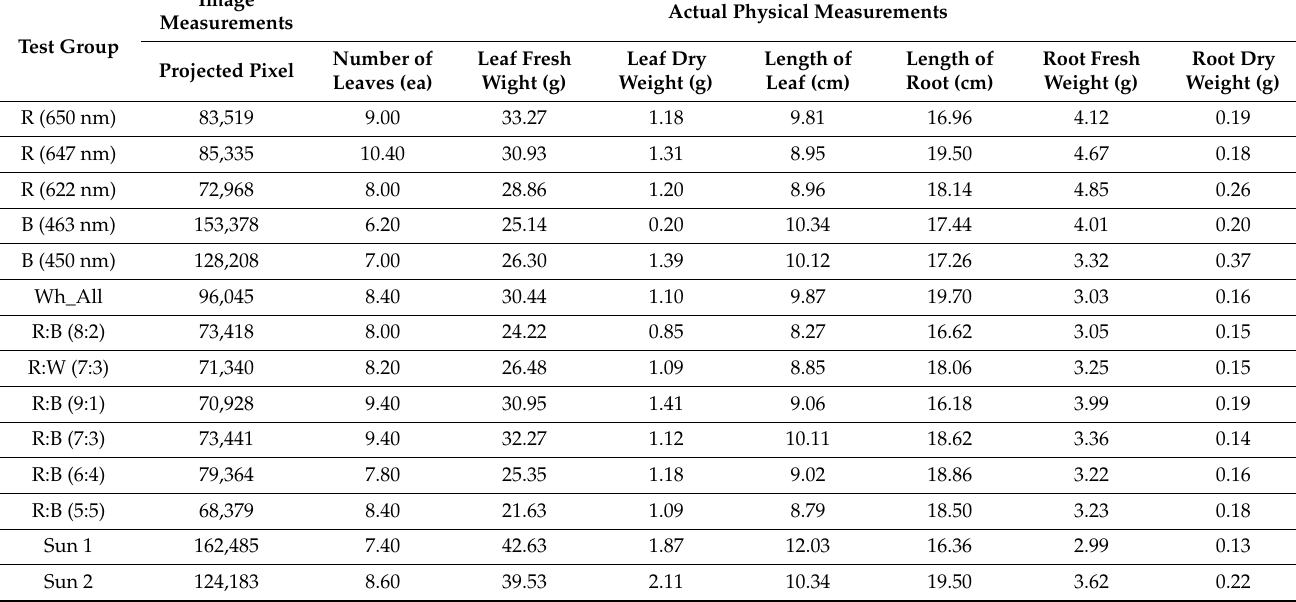
Table 1. Image measurements in accordance with arranged light sources and actual physical data measured.